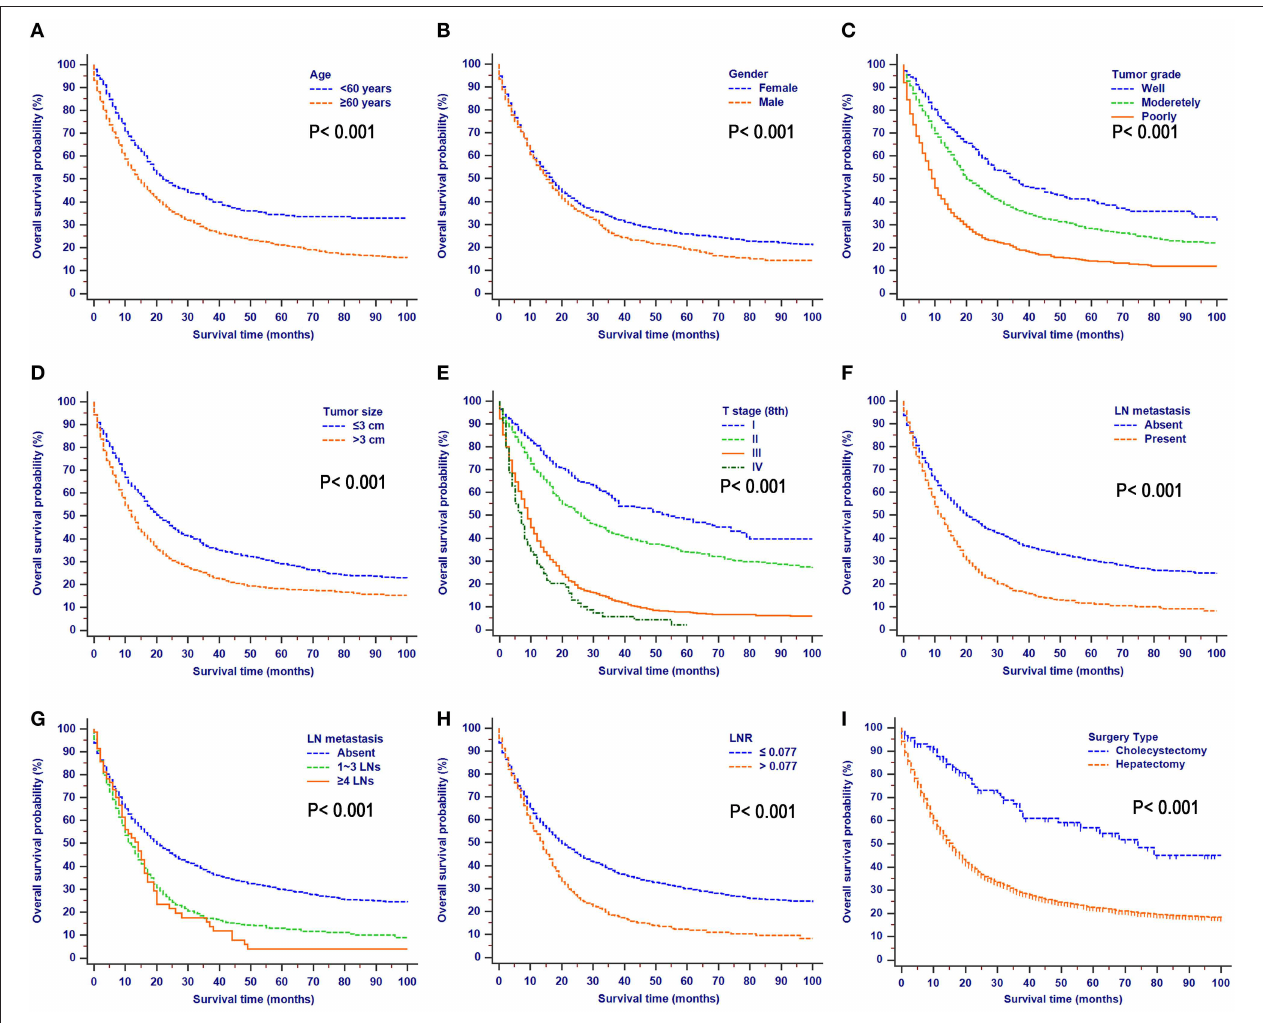
FIGURE 2 | Overall survival rates stratified by patient characteristics: (A) age; (B) gender; (C) tumor grade; (D) tumor size; (E) T stage (8th); (F) LN metastasis; (G) N stage (8th); (H) LNR; (I) surgery